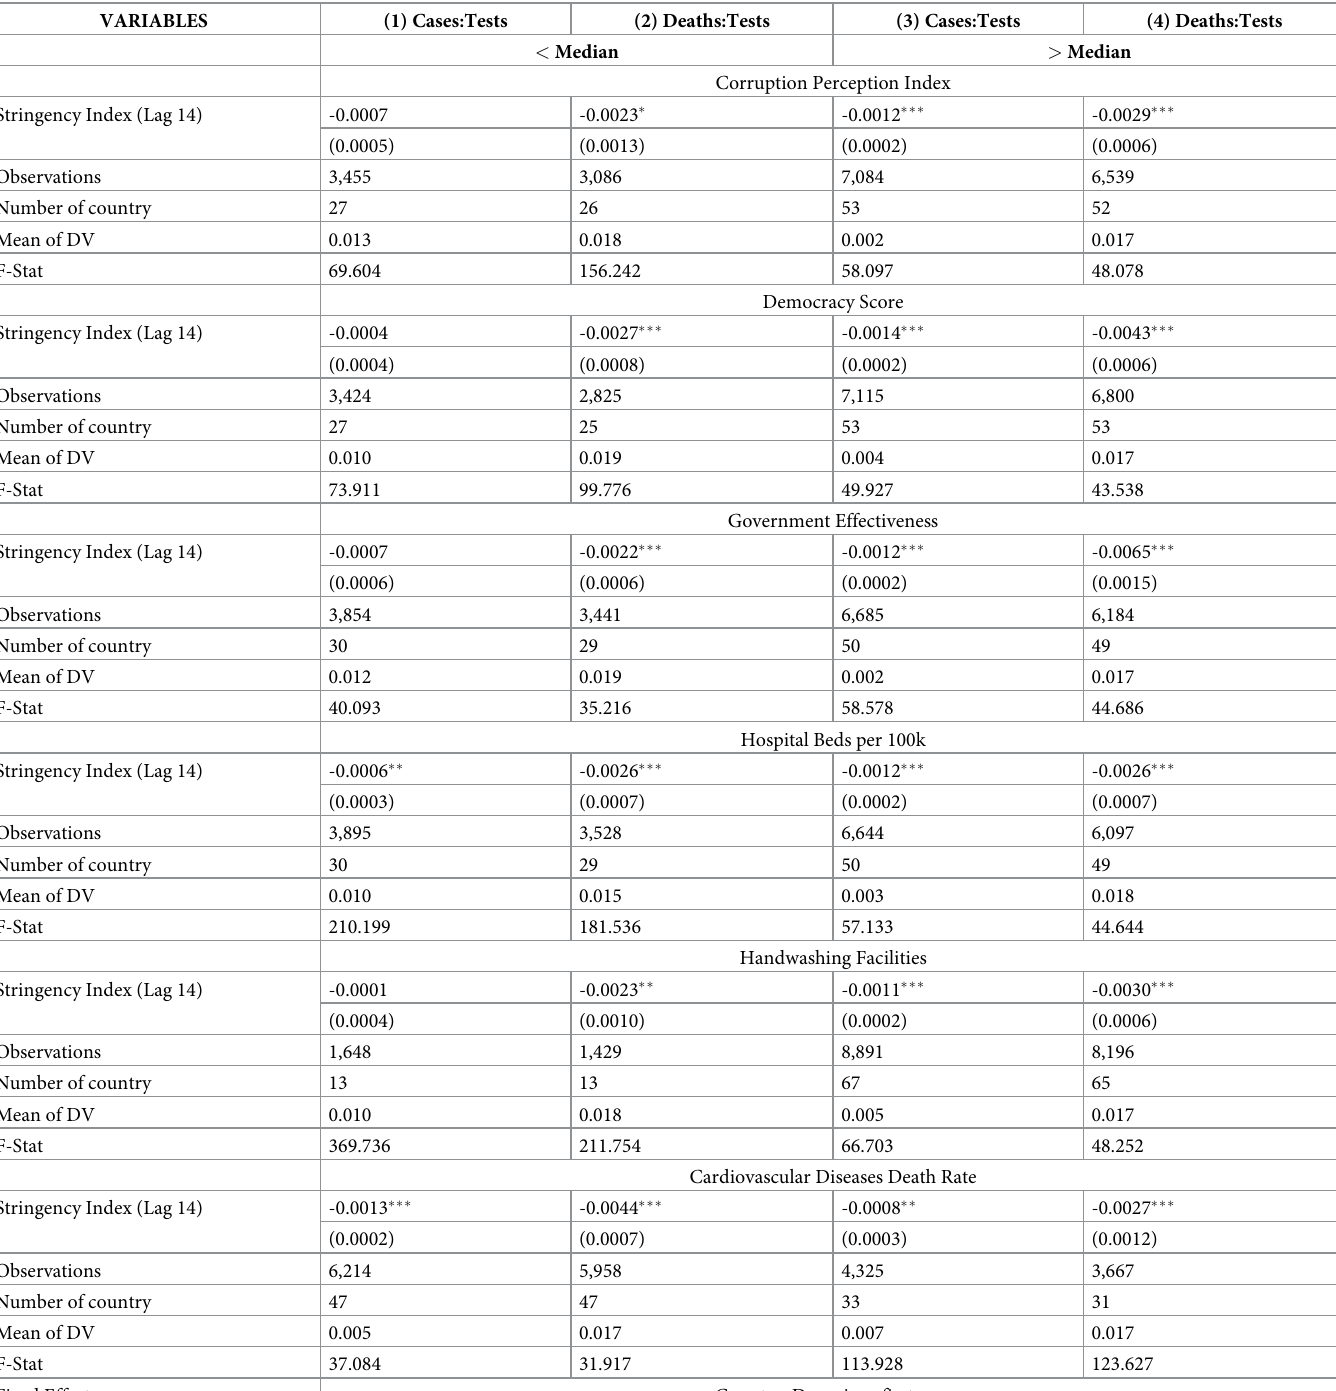
Table 7. Heterogenous impact of stricter restrictions on growth rates